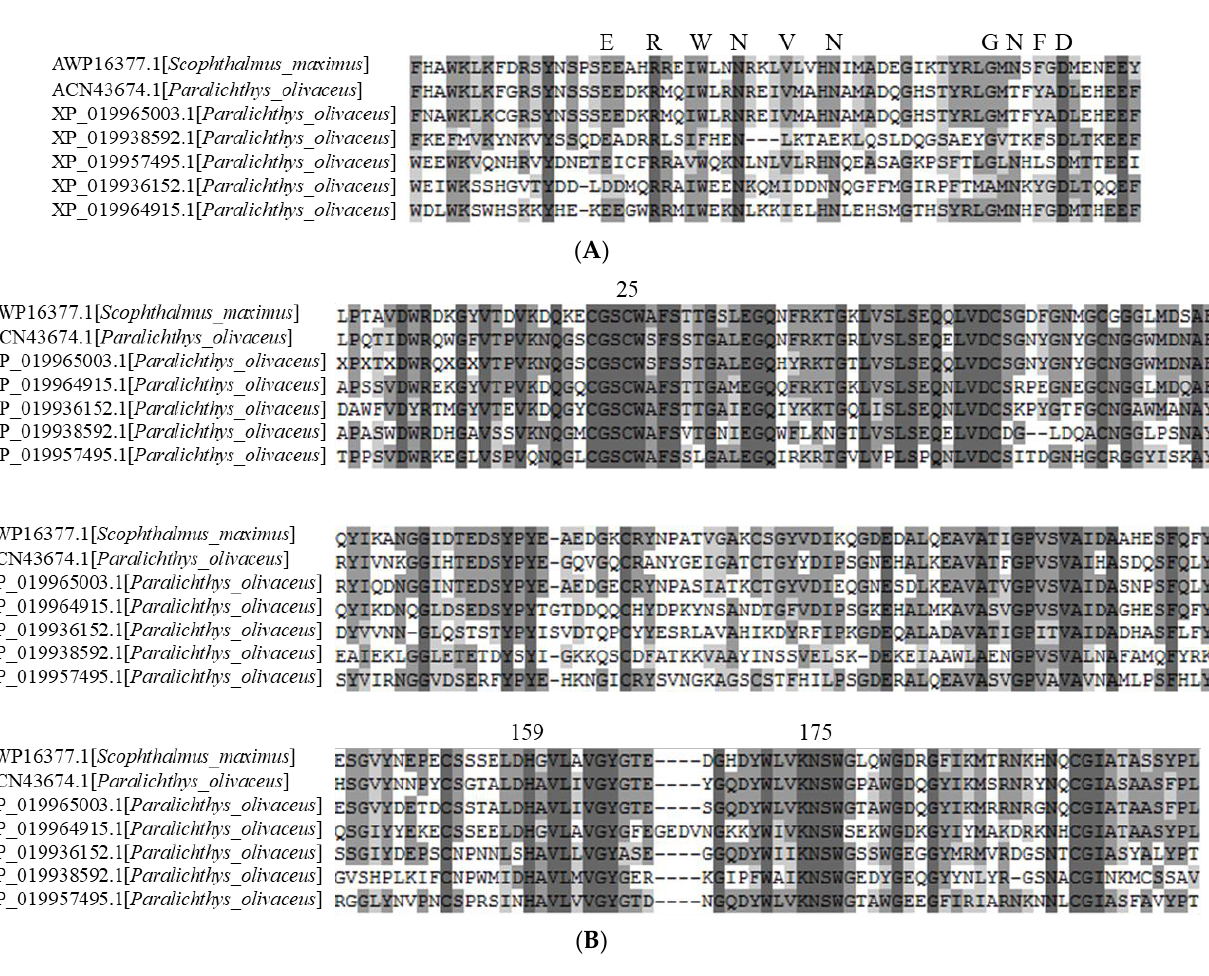
Figure 1. Multiple alignments of the deduced amino acid sequences of cathepsin Ls (olive flounder) with turbot. The deduced amino acid sequences of the inhibitor domain ( A ) and peptidase domain ( B ) were aligned by ClustalW. Identical and conserved amino acid residues are darkly shaded. Conserved signatures (ERWNVN and GNFD) and catalytic triad residues (C, H, and N) are highlighted in bold and indicated above the alignment.